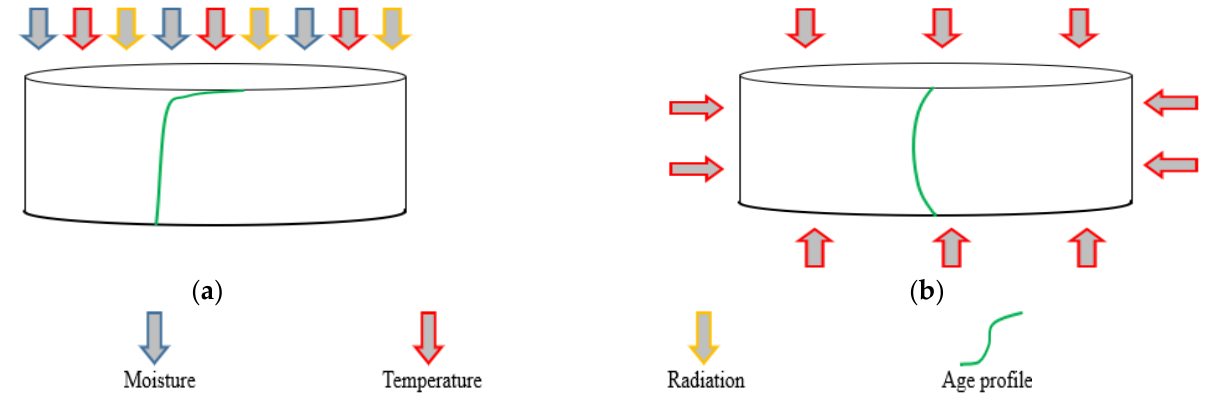
Figure 3. Schematic illustration of asphalt aged in the ( a ) field and ( b ) oven.